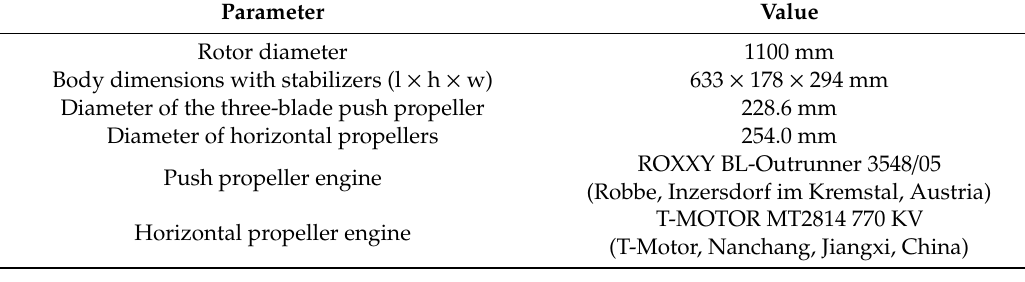
Table 1. Technical parameters of the tested aircraft.